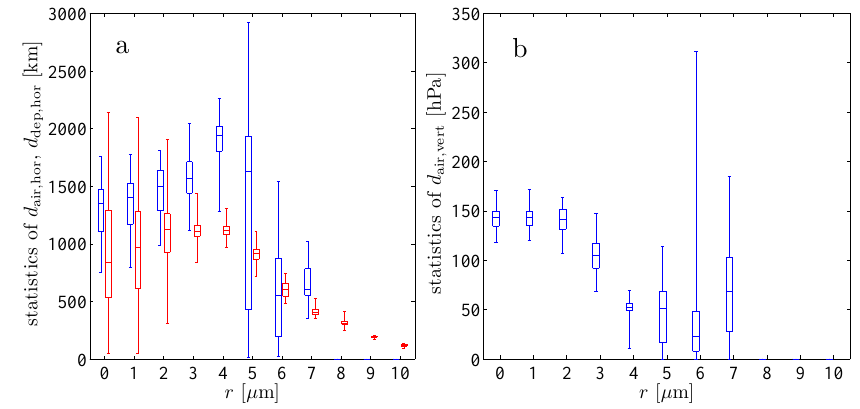
Fig. 7. The statistics of the root-mean-square clone distances d air , hor and d dep , hor in horizontal (a) and d air , vert in vertical (b) of the particles in the 50 ensemble members after 2.5 days averaged over the particles that remain in the atmosphere (blue) or deposit (red). Minima and maxima (horizontal line segments), lower and upper quartiles (the bottom and the top of the boxes), and medians (horizontal lines in the boxes) are plotted.